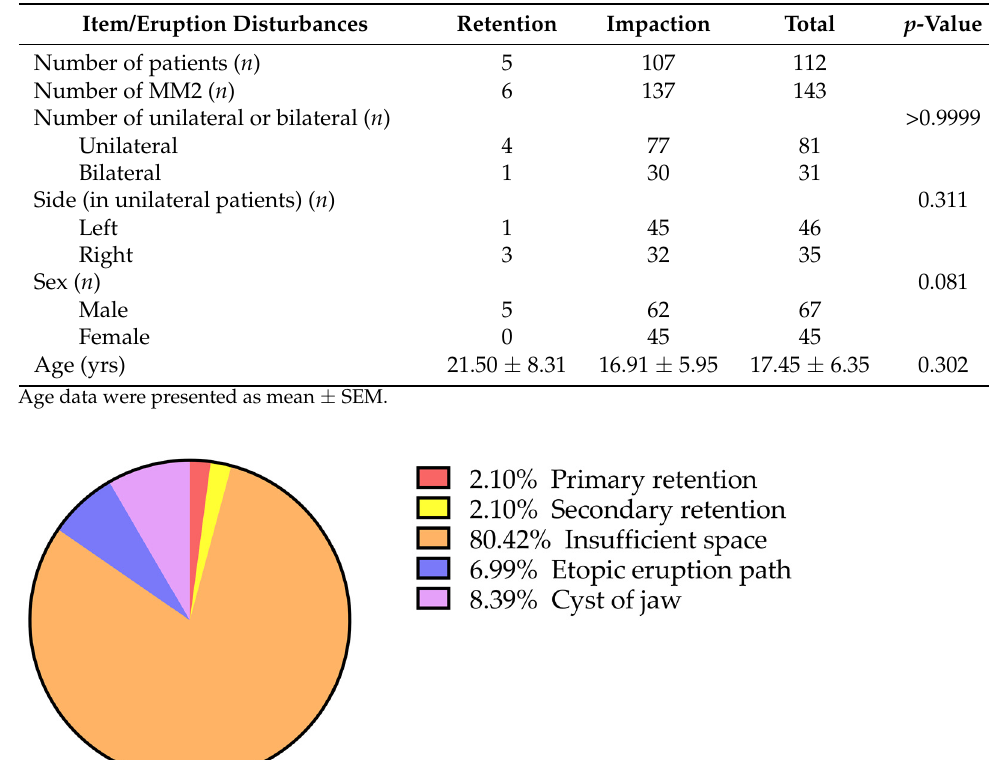
Table 1. Patient demographics and baseline information based on impaction and retention.